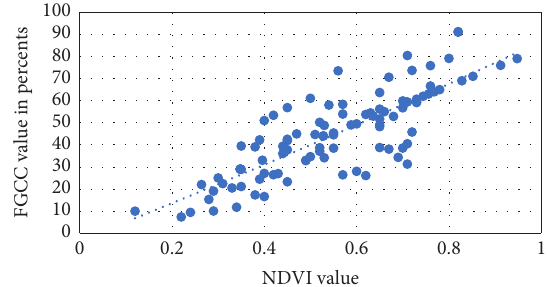
Figure 8: Approximation of the polynomial model for NDVI into FGCC conversion for tomato.